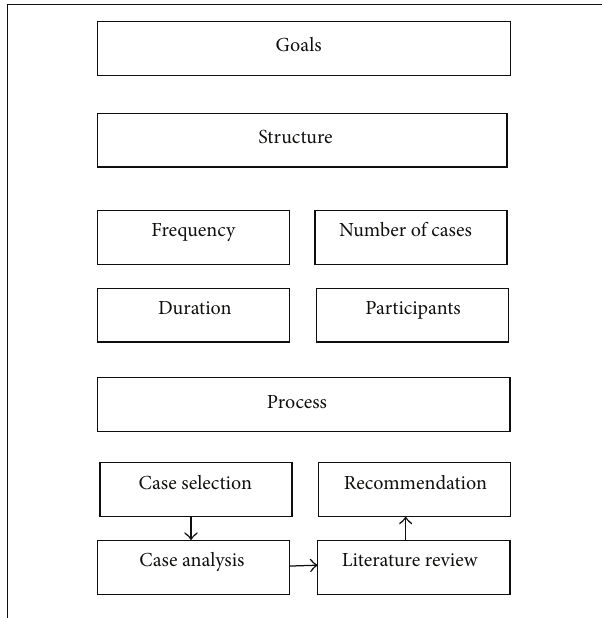
Figure 1: Proposed characteristics of MMC, modified with permis- sion from Aboumatar et al.